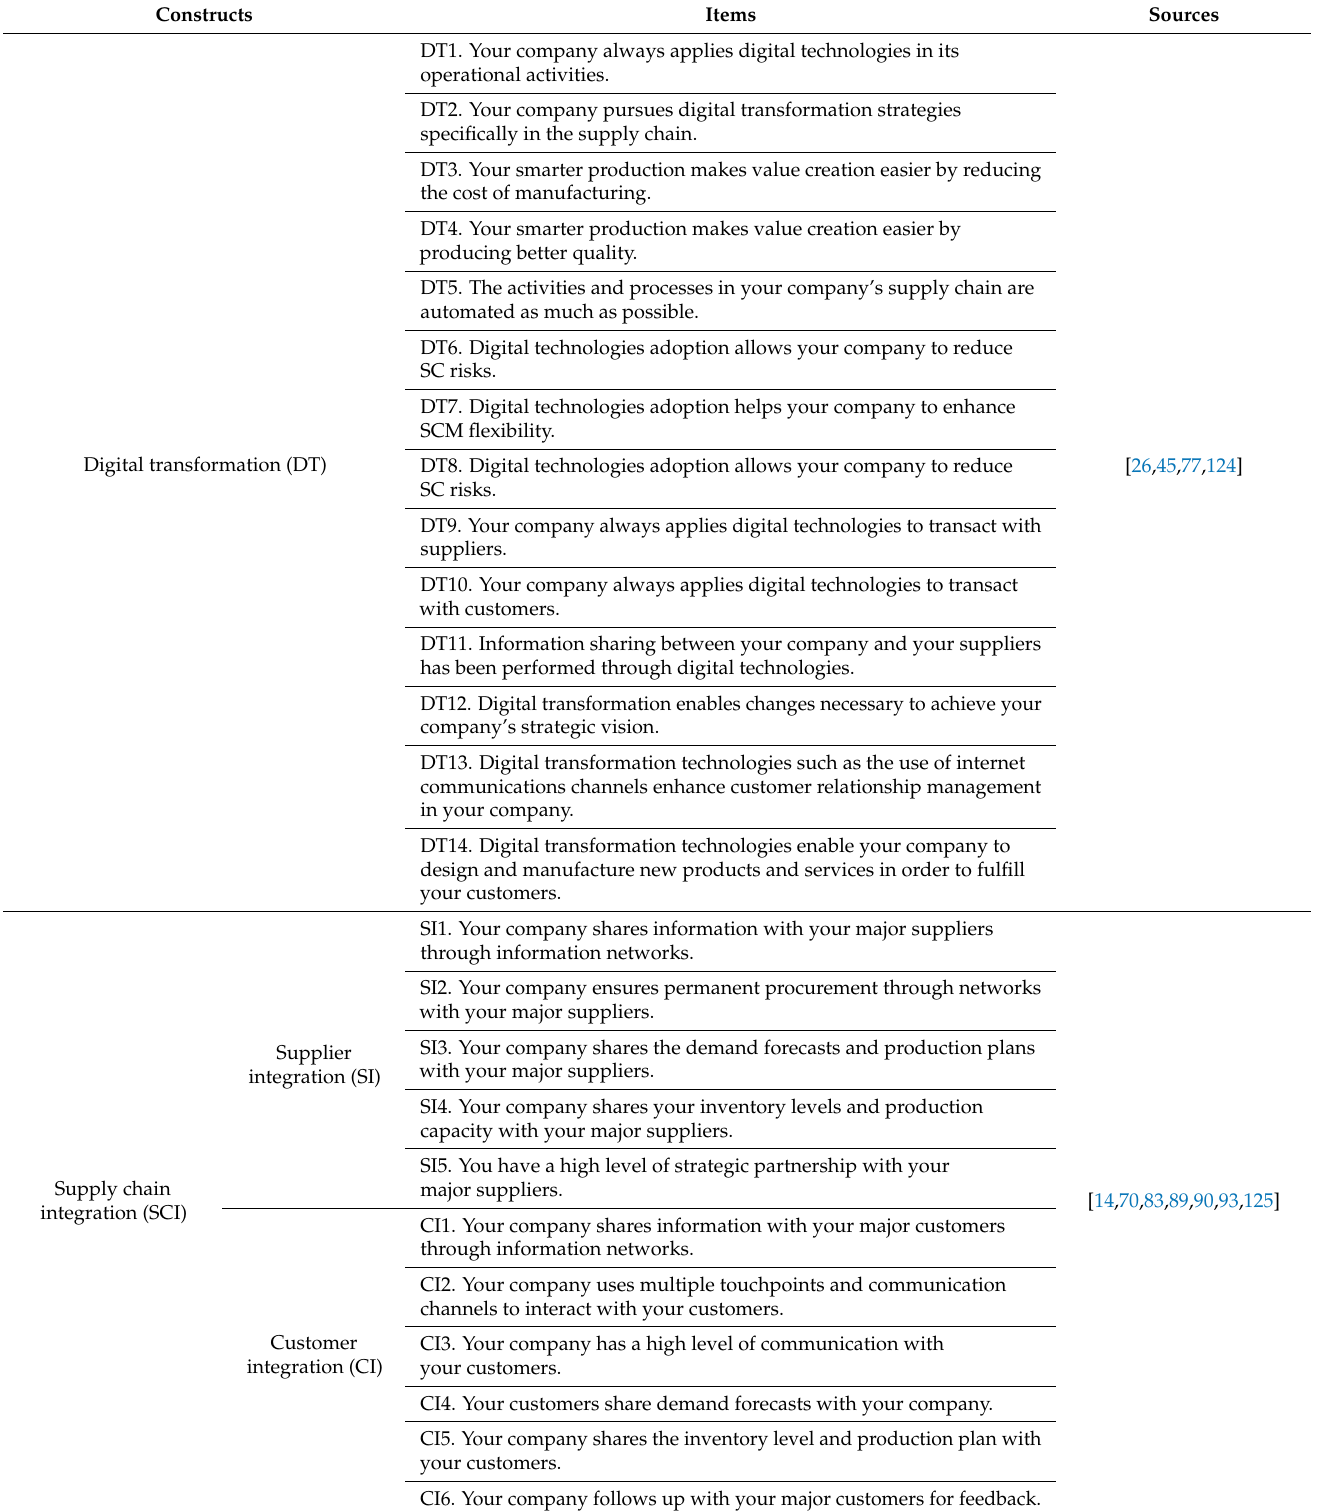
Table A1. Constructs and their measurement